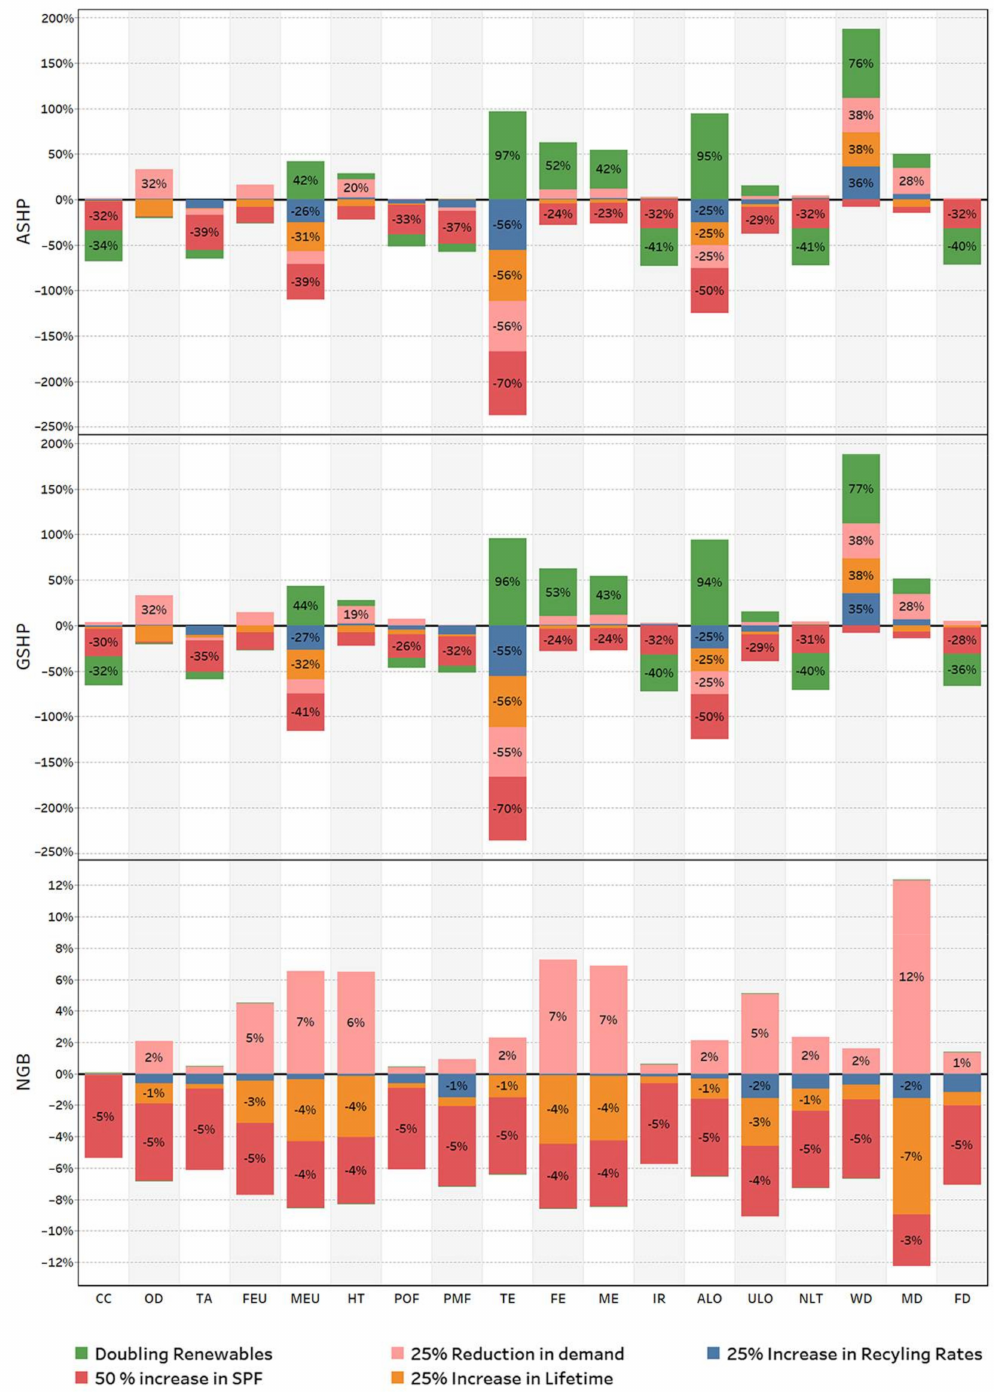
Figure 9. Impacts of different parameters on environmental results for heating technologies in sensitivity